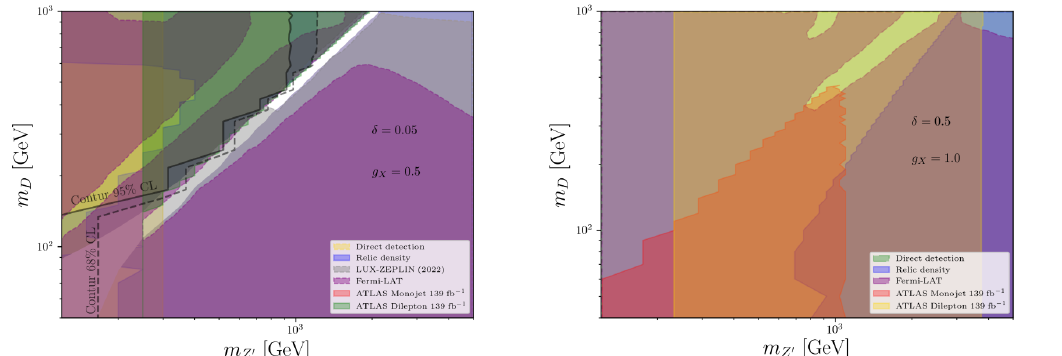
Figure 4 . Constraints on the Stueckelberg model in the DM- Z 0 mass plane for two choices of δ and g X . Limits from direct detection experiments, monojet and dilepton searches as well as the relic density constraint eliminate most of the parameter space except near the resonance region for smaller δ and g X (left